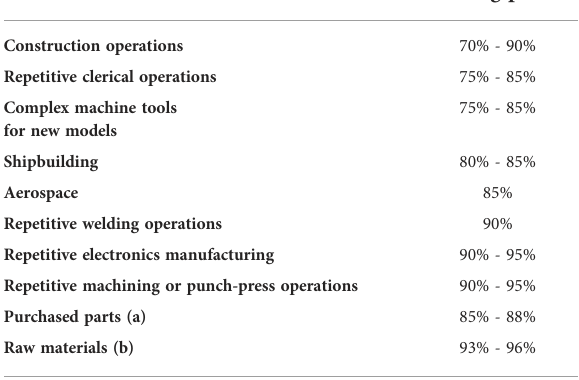
TABLE 1 General industry learning curve